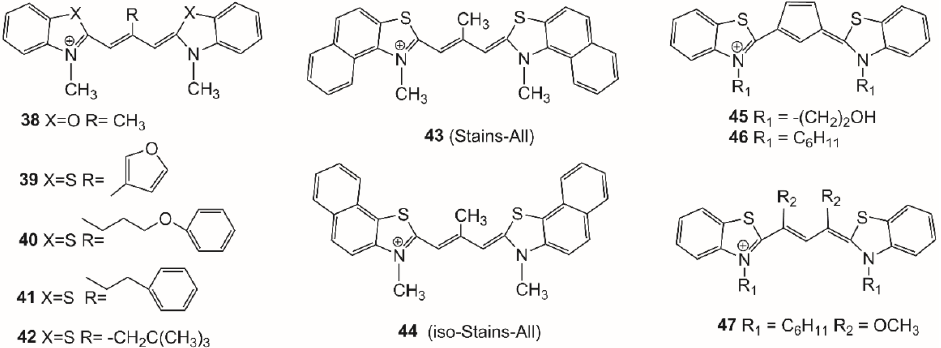
Figure 10. Structures of oxa ‐ and thia ‐ trimethine cyanines 38 – 47 .